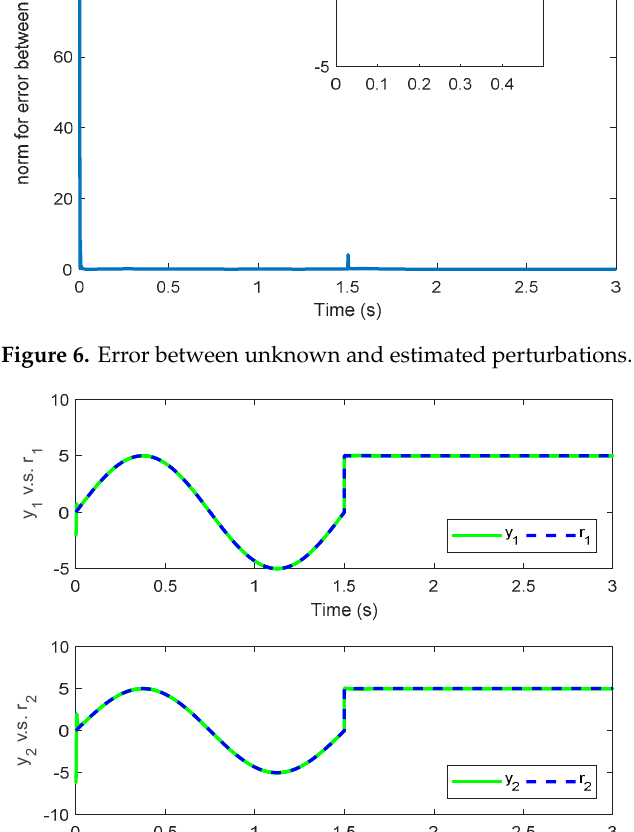
Figure 7. Figure 7. Time responses of the closed-loop system with the flexible PID controller and unknown